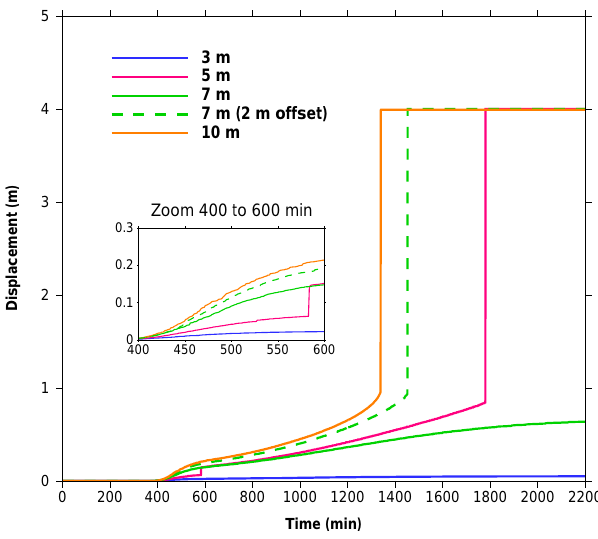
Figure 16. Effects of tree spacing on slope displacement at the cen- ter ( x = y = 0) for five different tree spacings and spatial configu- rations. Inset shows details at early stage of displacement and the failure of roots across the tension crack at 580min for the 5m tree